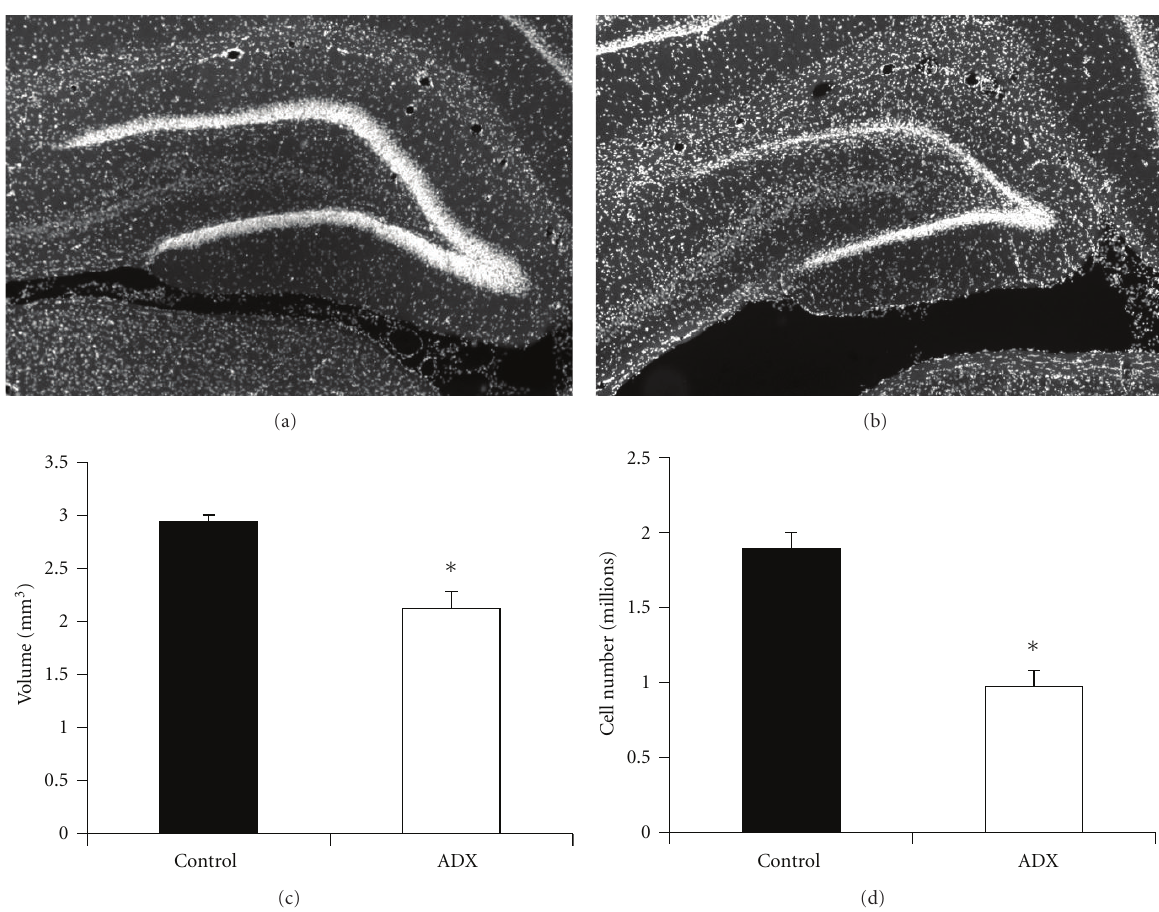
Figure 2: Representative DAPI-labeled sections containing the dentate gyrus granule cell layer in a control (a) and an adrenalectomy (ADX) rat (b) after 10 weeks of degeneration. (c) By 10 weeks, ADX rats had lost approximately one-third of the volume of the dentate gyrus granule cell layer when compared to adrenally intact controls. (d) Cell counts using the optical fractionator revealed a loss of roughly half of the dentate gyrus granule cells at the same time point. ∗ indicates significant di ff erence; error bars represent standard error of the mean (adapted from